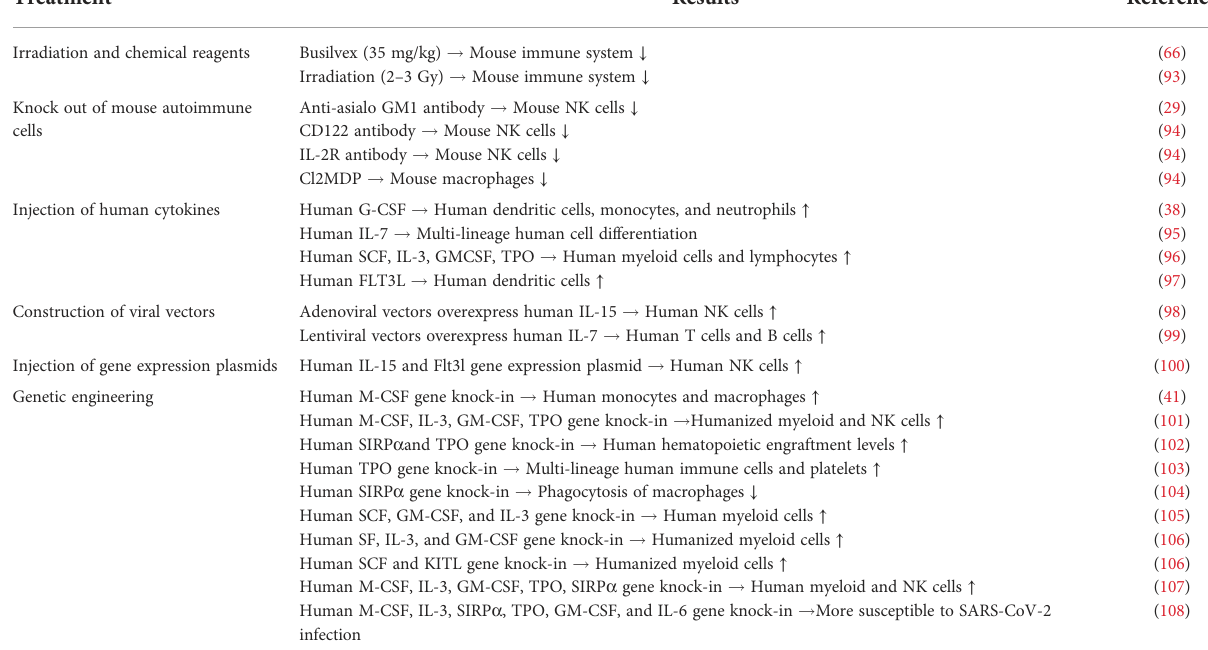
TABLE 2 Improvement of humanized immune system mouse models.